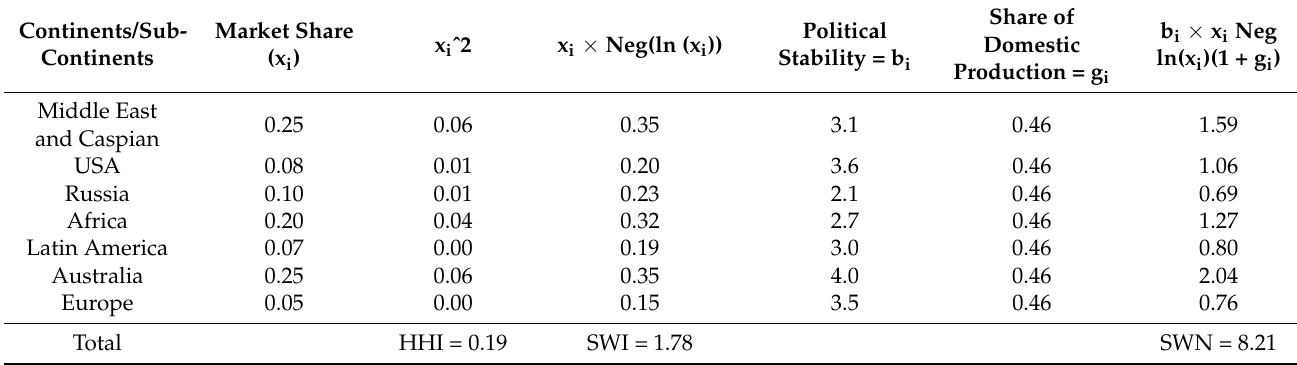
Table 6. India’s Energy Security Indicators with respect to the importation of natural gas (2030 projection). Continents/Sub-